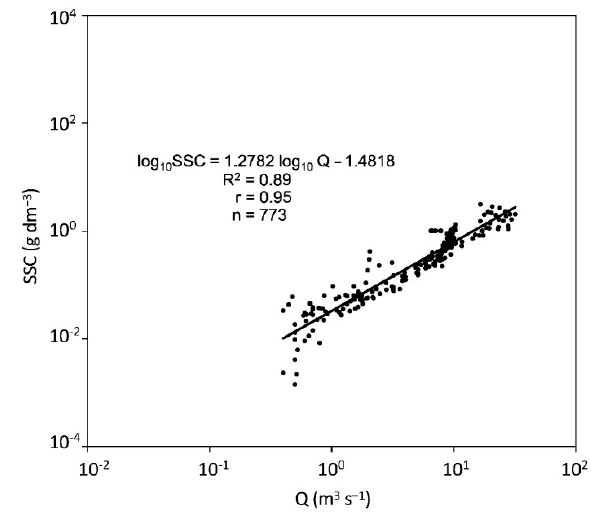
Figure 3. The duration of suspended sediment concentration (SSC) monitoring in Breelva. The days of sampling (2 or 3 samples a day) in each year (1972, 1986, 2007, 2008, 2010, 2011, 2012). Figure 4. The correlation (r-Pearson) between the suspended sediment concentration (log 10 SSC (g dm − 3 )) and discharge (log 10 Q (m 3 s − 1 )) at the Breelva hydrometic station.